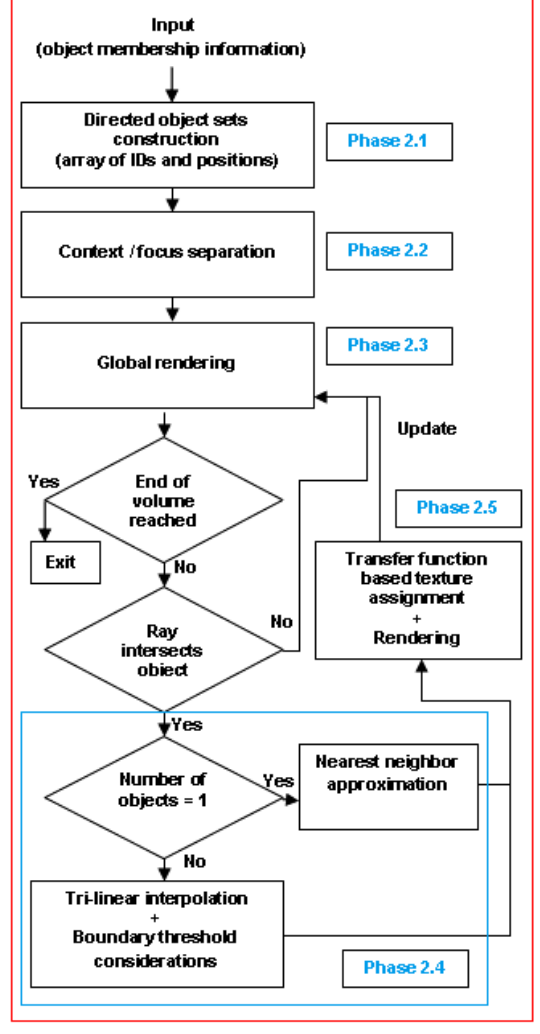
Figure 12. An enhanced rendering architecture.